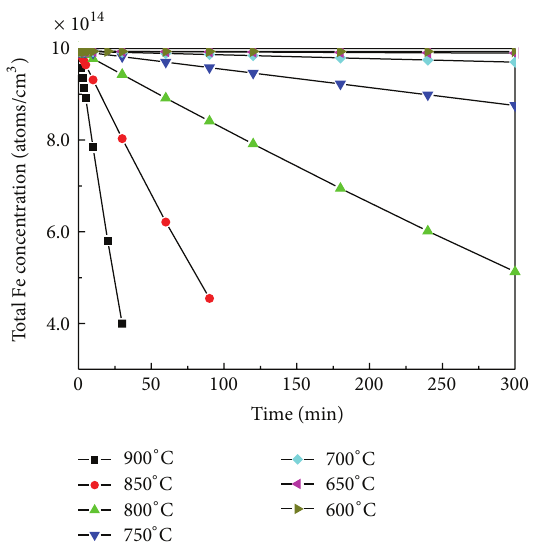
Figure3:CalculatedinterstitialFeconcentrationaveragedthrough- out the Si wafer after the gettering process with different tem- peratures and times. The initial concentration of the interstitial iron atoms was assumed to be 1 × 10 12 atoms/cm 3 . For higher temperatures than 750 ∘ C, the interstitial Fe concentration increased withtime,whichmightbeoriginatedfromtheincreaseofironatoms migrated from the precipitate sites at higher temperature.